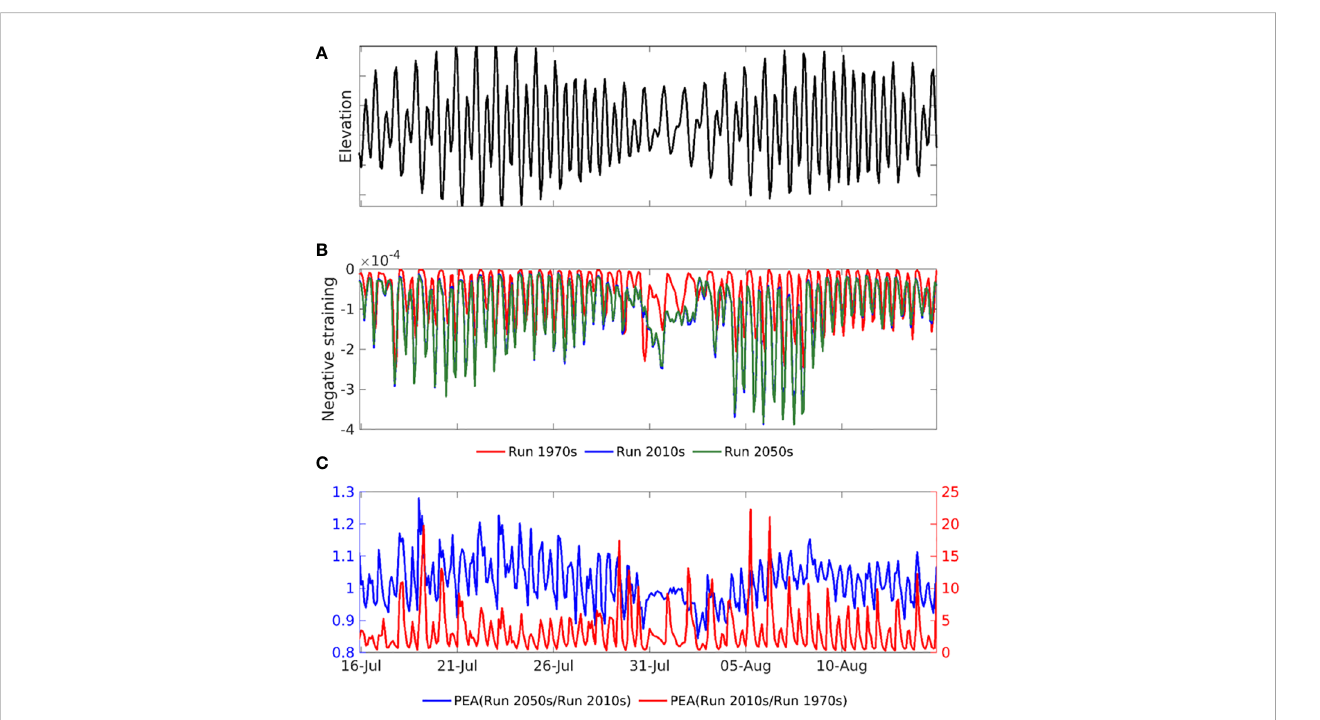
FIGURE 8 Time series of (A) water level, (B) straining and (C) magni fi cation of negative straining due to morphologic change and sea-level